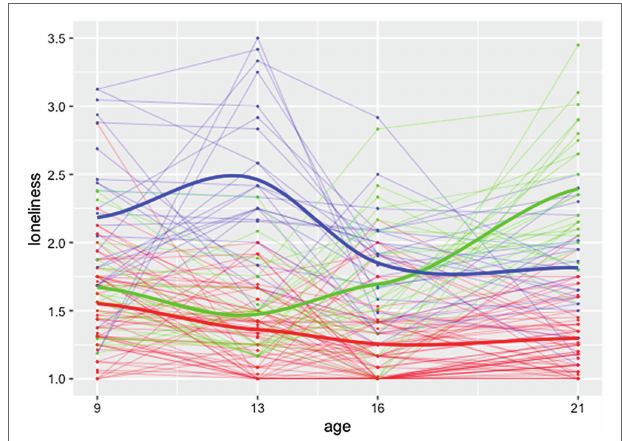
TABLE 4 | Results of the regression analysis predicting anxiety at age 21.